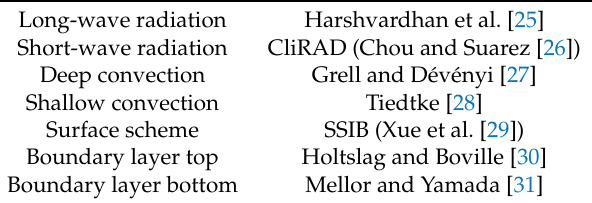
Table 1. Parameterizations of physical processes in the BAM model used in this